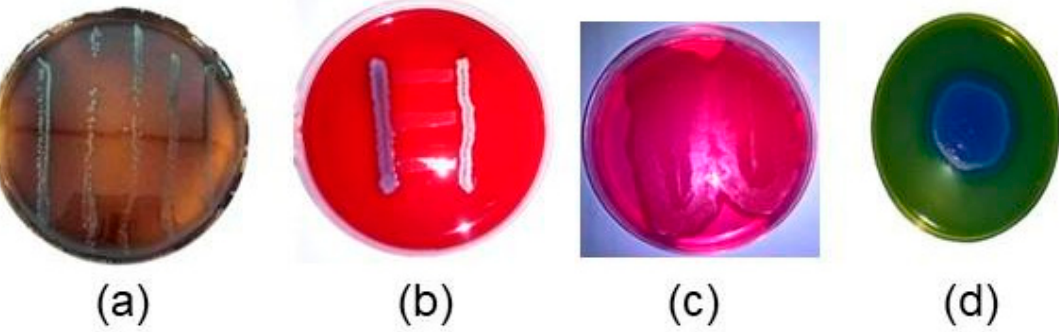
Figure 3. ( a ) Listeria monocytogenes on listeria selective agar (LSA) media ( b ) Christie Atkins Munch